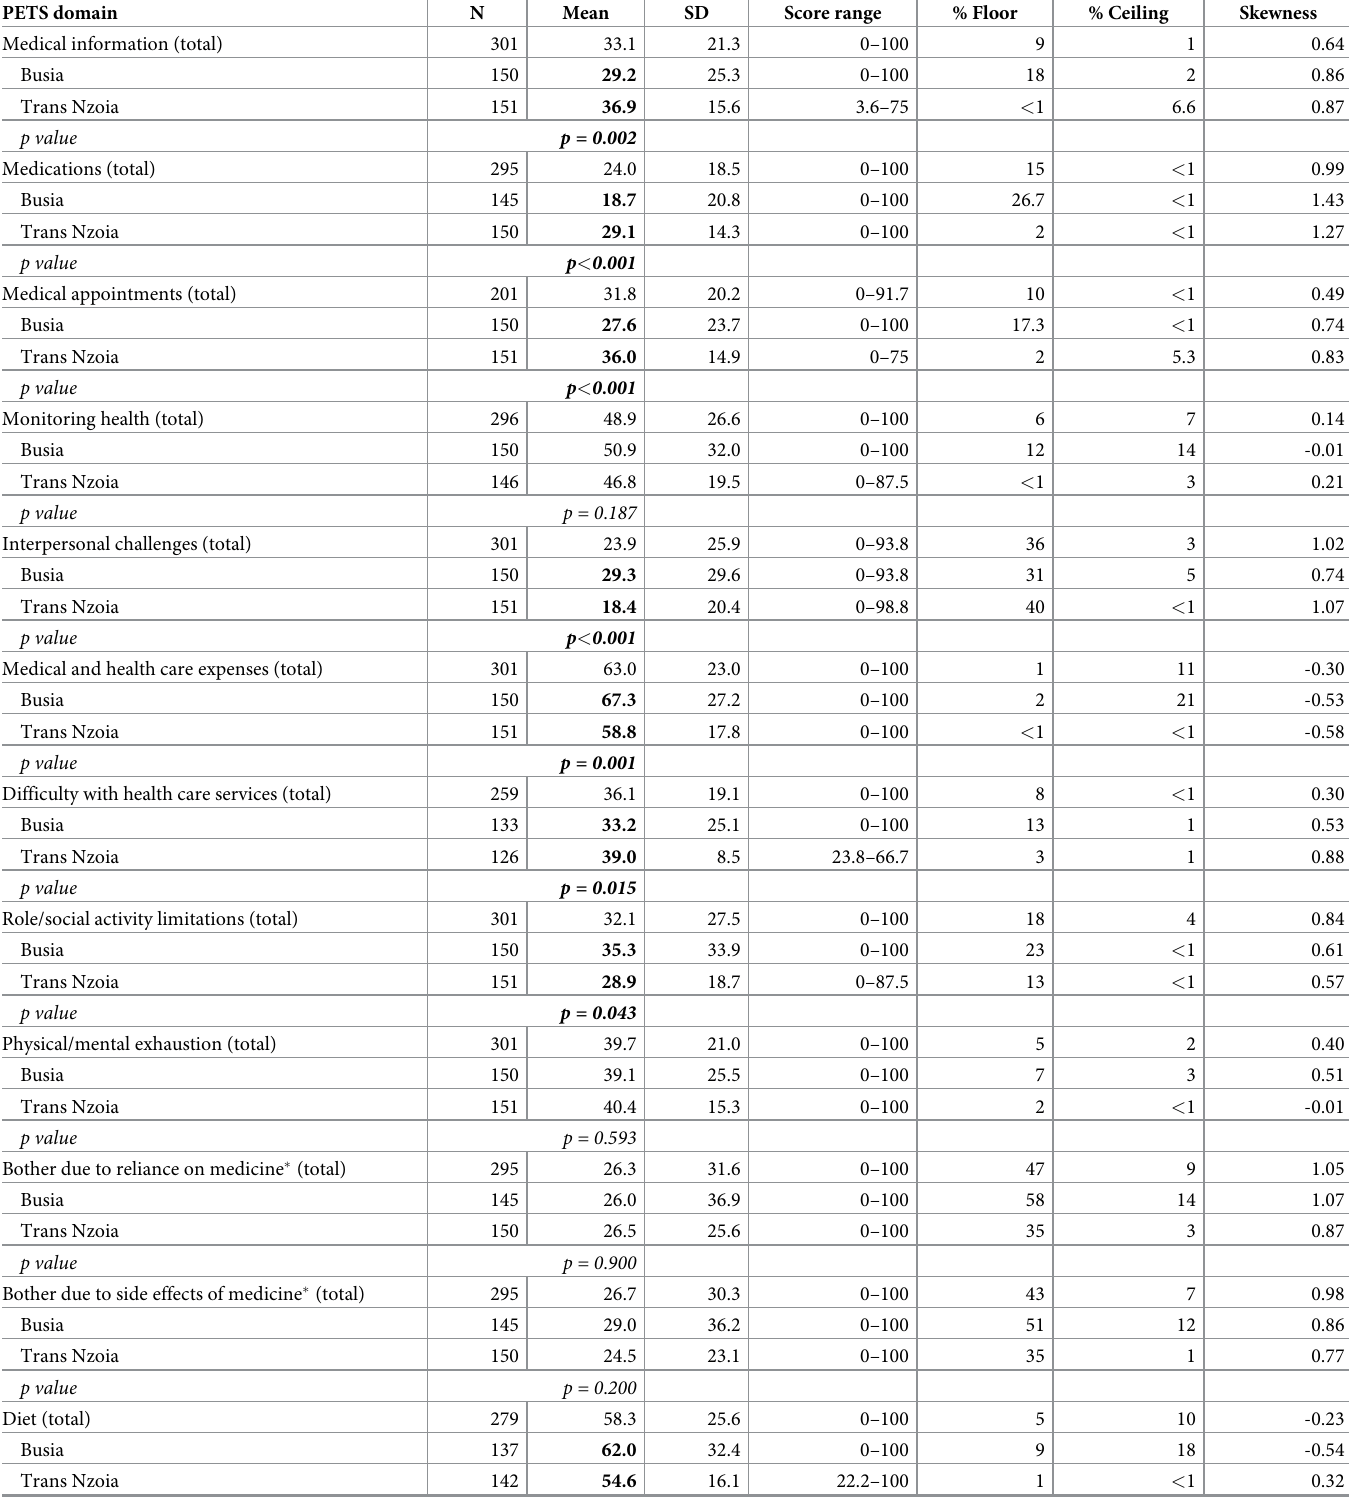
Table 3. Descriptive statistics of 11 PETS domain scale scores and two single-item